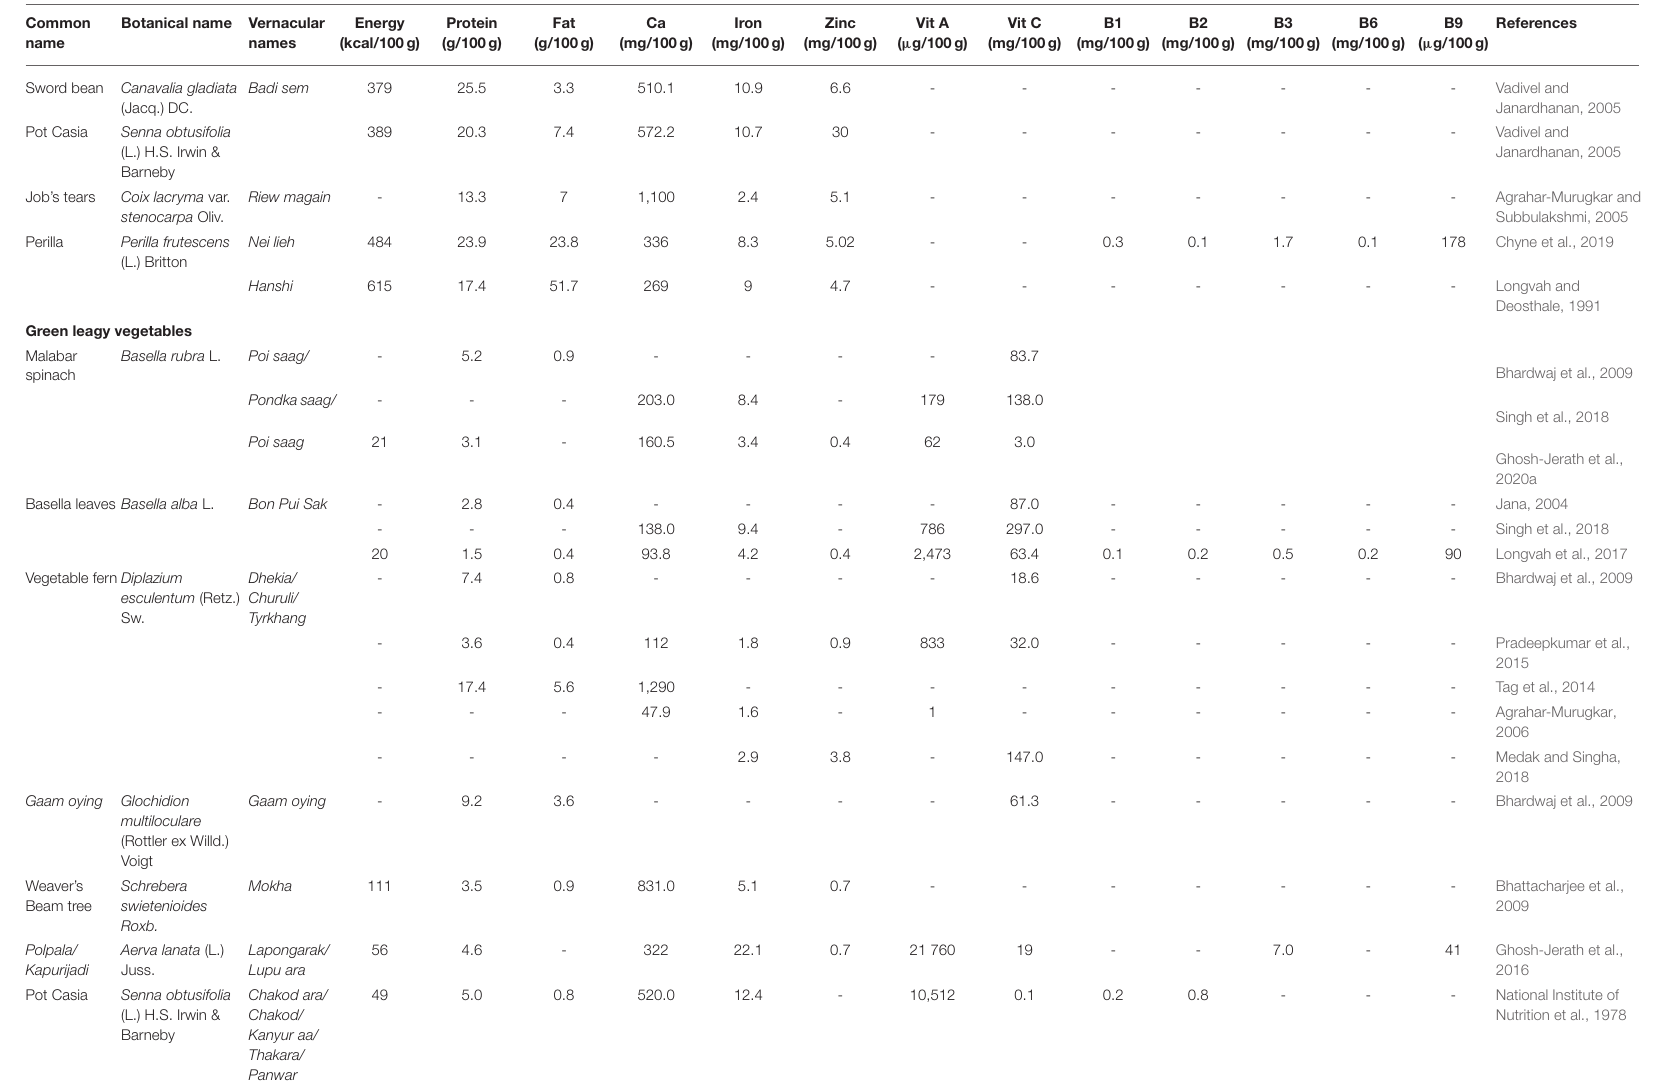
multiloculare (Rottler ex Willd.) Voigt Schrebera swietenioides Roxb. Aerva lanata (L.) Juss. (L.) H.S. Irwin &